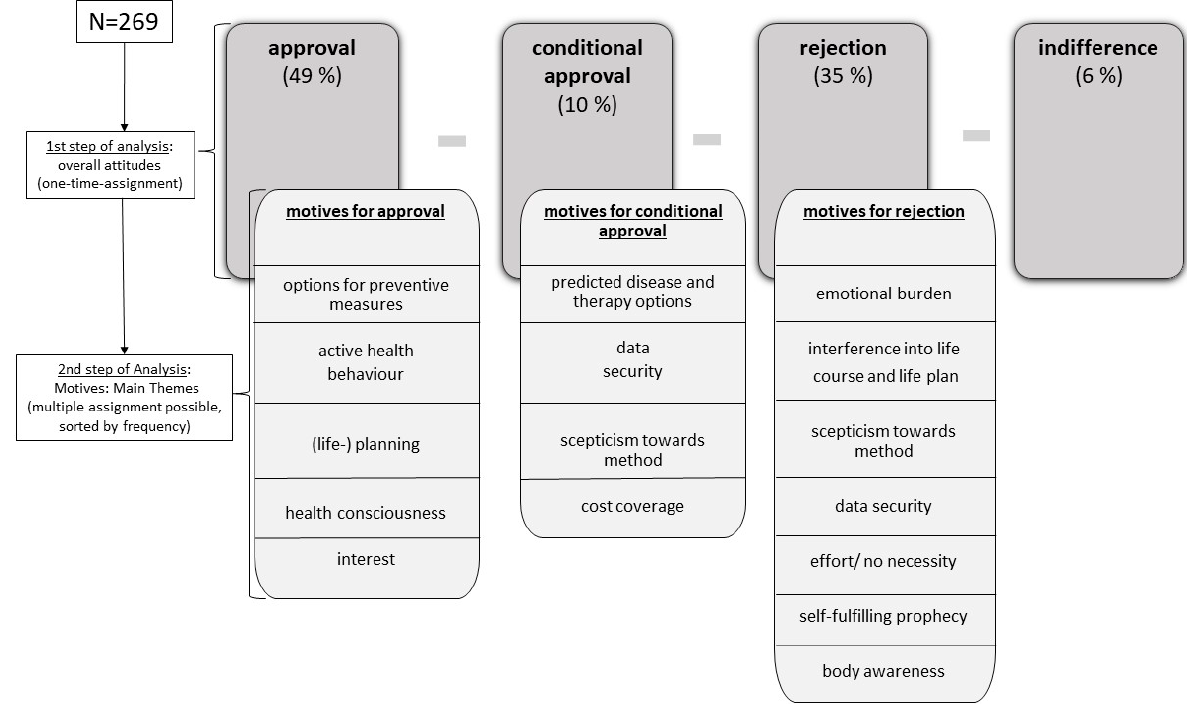
Figure 1. Overview of the two-stage analysis procedure resulting in overall attitudes (approval, conditional approval, rejection, indifference) and the inherent motive categories.